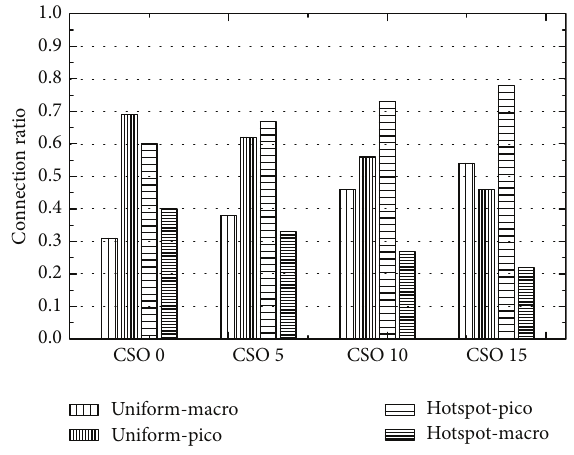
Figure 5: Connection ratio with different CSOs.